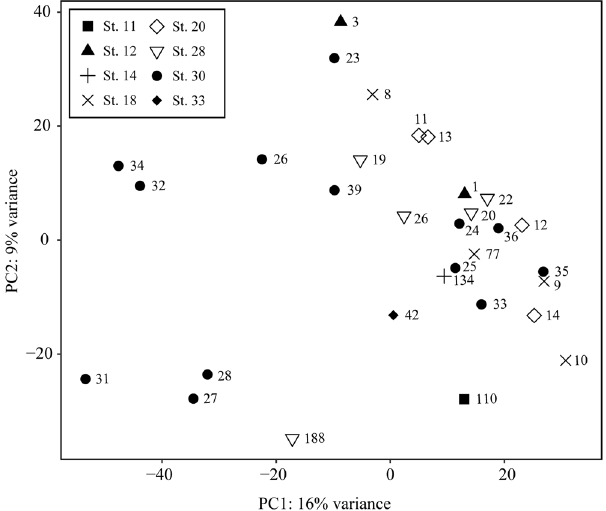
Figure 5. Principal component analysis (PCA) of the similarities in 18S rRNA gene composition of the marine snow particles, across stations, based on relative read abundances. Symbols indicate sampling station, and numbers the snow particle